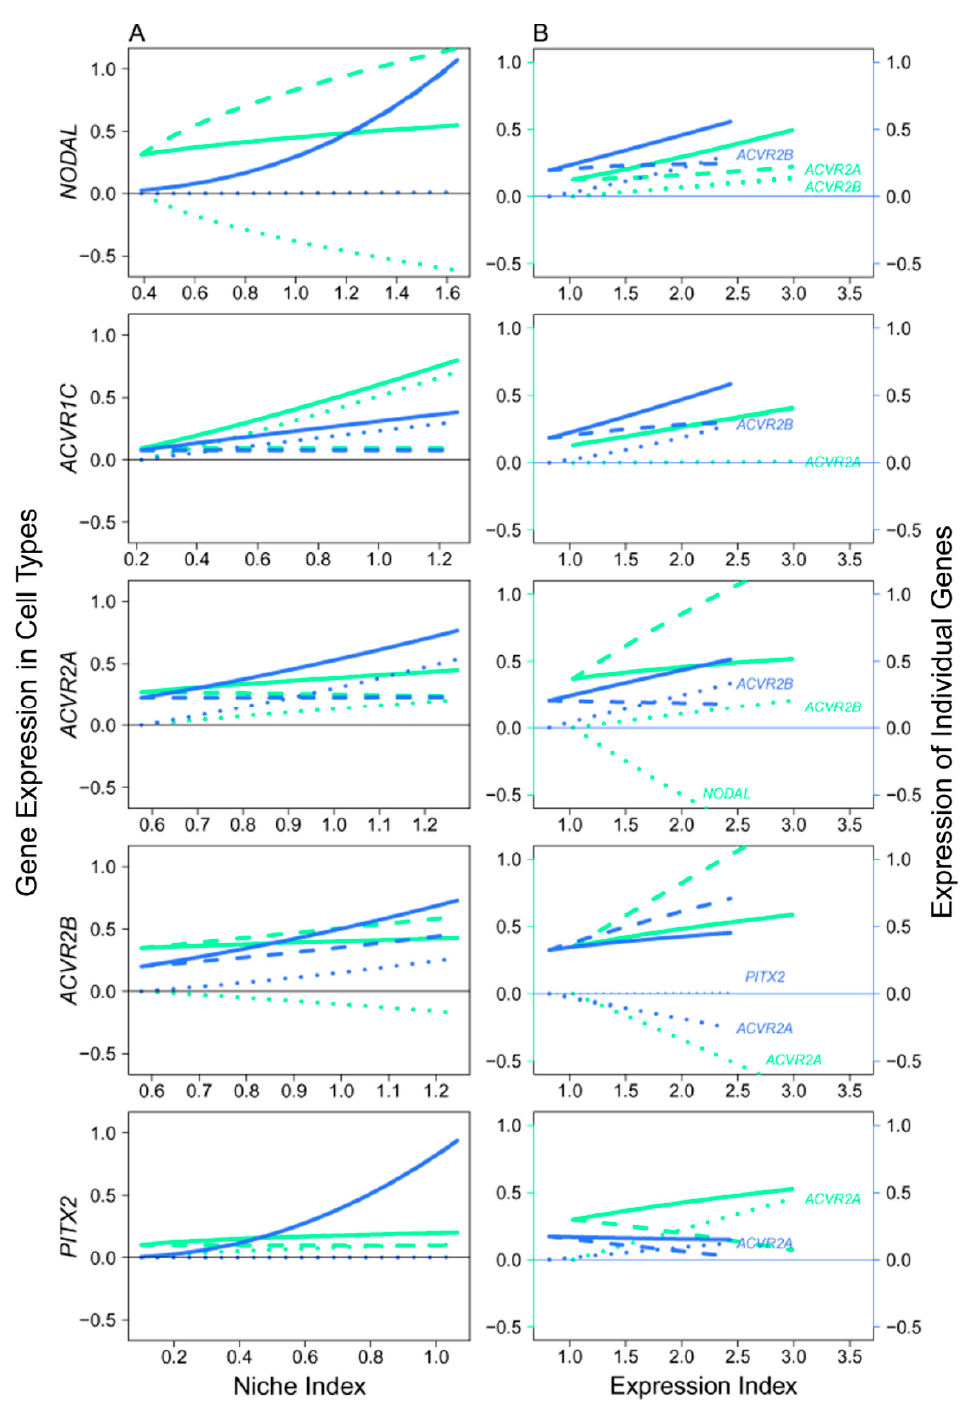
Figure 8. Mitotic–meiotic interactions driven by genes involved in the NODAL signaling pathway, where NODAL is the ligand expressed in mitotic FGCs, ACVR1C , ACVR1A , and ACVR1B are the receptors and PITX2 is the target, with both receptors and target being specifically expressed in meiotic FGCs. ( A ) The niche index-varying pattern of interactions between mitotic FGCs (green) and meiotic FGCs (light blue) driven by individual genes. Solid thick lines, slash lines, and dots lines denote the overall expression level, independent expression level, and dependent expression level, respectively. ( B ) NODAL , ACVR1A , ACVR1B , ACVR1C , and PITX2 worked together in a network to mediate mitotic and meiotic phases of FGC development as a function of expression index, respectively. Left and right sides of the figure denote the expression levels of genes in mitotic FGCs (green) and meiotic FGCs (light